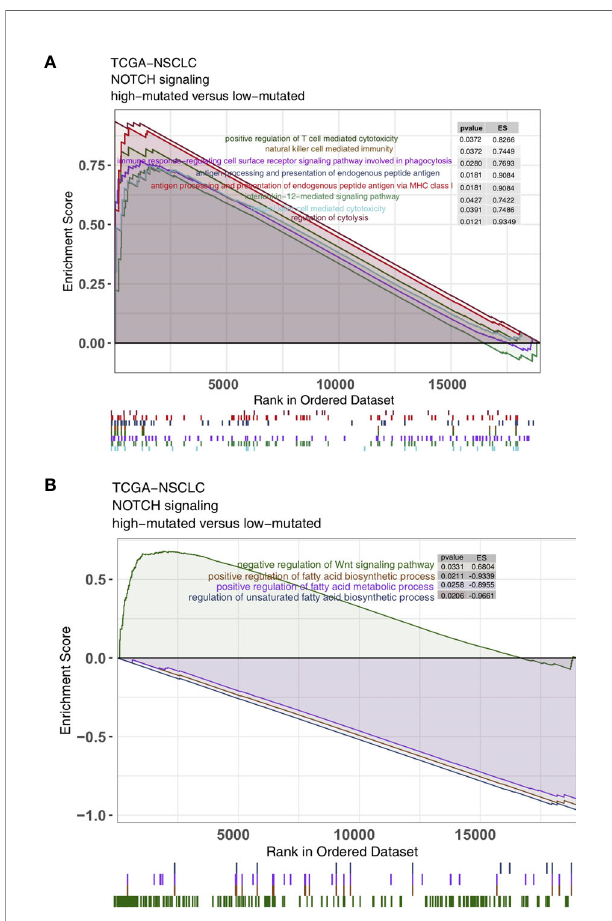
FIGURE 6 | Results of the gene set enrichment analysis (GSEA). (A) The immune cell pathways were signi fi cantly enriched in the high-mutated NOTCH group. (B) The exhausted immunological pathways were signi fi cantly downregulated in the high-mutated NOTCH group. The following subgroups served as control groups: low-mutated NOTCH. Enrichment score (ES) > 0 indicates that the corresponding pathways were signi fi cantly enriched in the experimental groups. The colors of the curves correspond to the font colors of the pathway